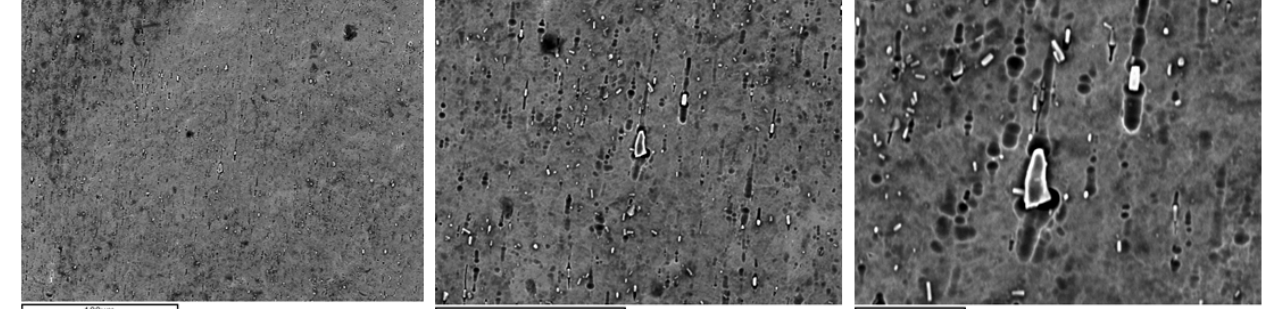
Figure 5. Precipitates formed in NiTi archwire after 28 days in NaF solution (380 ppm). The images have different magnifications.